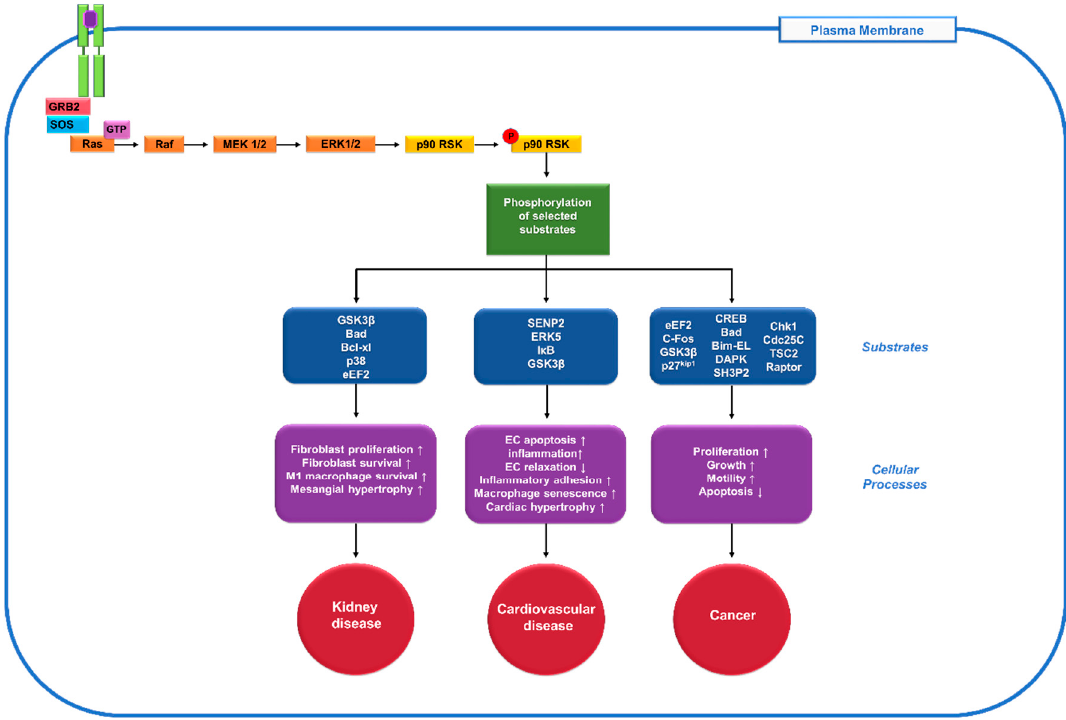
Figure 1. Role of the 90 kDa ribosomal s6 kinases (p90RSK), one of the downstream mediators of extracellular signal-regulated kinase (ERK) pathway, in diseases. When the receptor tyrosine kinase (RTK, green) gets activated by a ligand (purple), it stimulates the activation of the docking proteins growth factor receptor-bound protein 2 (GRB2) and son of sevenless (SOS). SOS helps remove the guanosine diphosphate (GDP) from Rat sarcoma (Ras), allowing it to bind guanosine triphosphate (GTP) and become activated. The Ras signalling cascade begins as Ras activates the Raf kinase, which phosphorylates mitogen-activated protein kinase kinase (MEK1/2), extracellular signal-regulated kinase 1/2 (ERK1/2) and p90RSK. Then p90RSK phosphorylates various downstream substrates (blue) to mediate diverse cellular processes (purple) and contribute to numerous human diseases including kidney disease, cardiovascular disease and cancer (red).